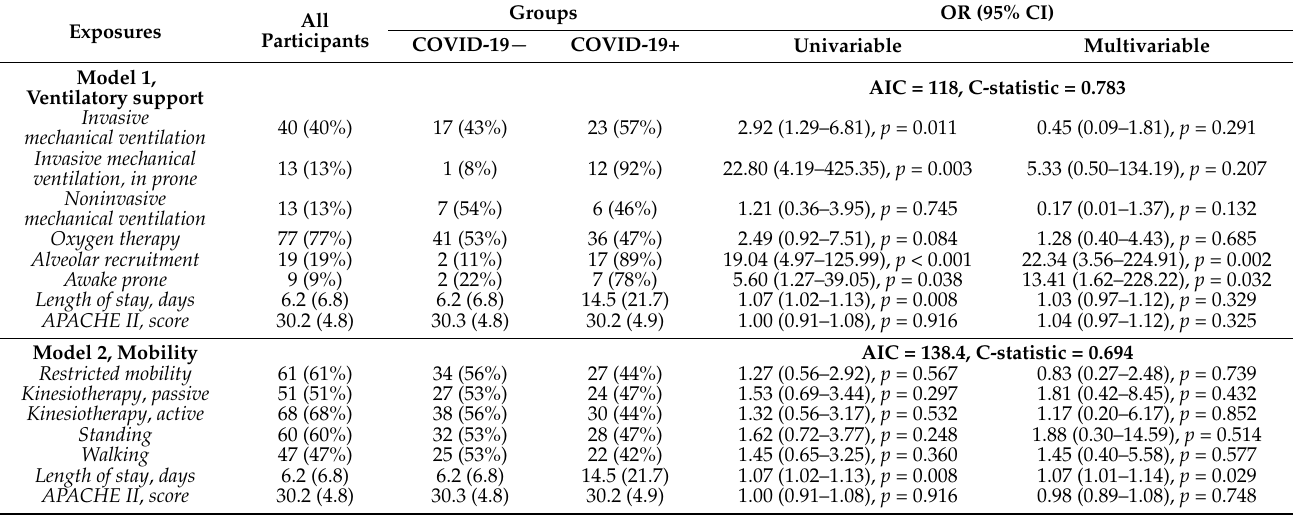
Table 2. Association (odds ratio and 95% confidence intervals) of COVID-19 test (positive vs. negative) and the exposure to the physiotherapy interventions (yes vs. no) estimated using univariable and multivariable logistic regression models ( n =